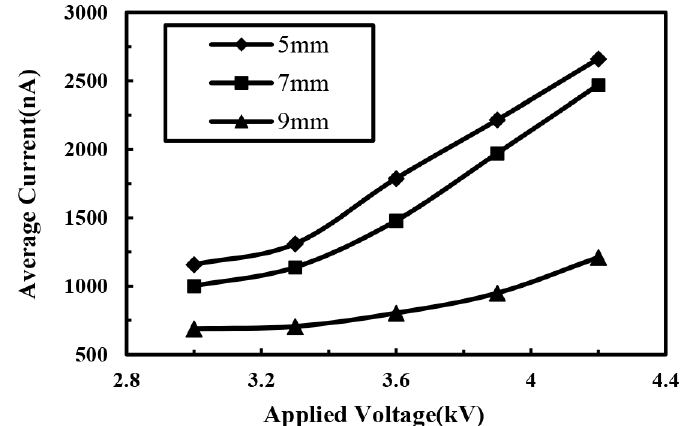
Figure 7. Relationship between average electrohydrodynamic direct-written current and applied voltage at different distances between spinneret and collector. The solution concentration and the solution supply rate were 10% and 100 μL/h, respectively.